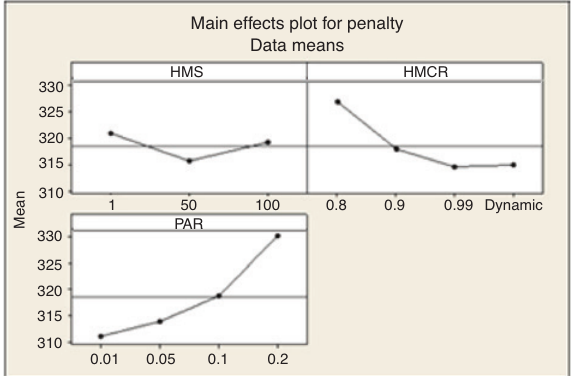
Figure 2: Main Effects Plot of